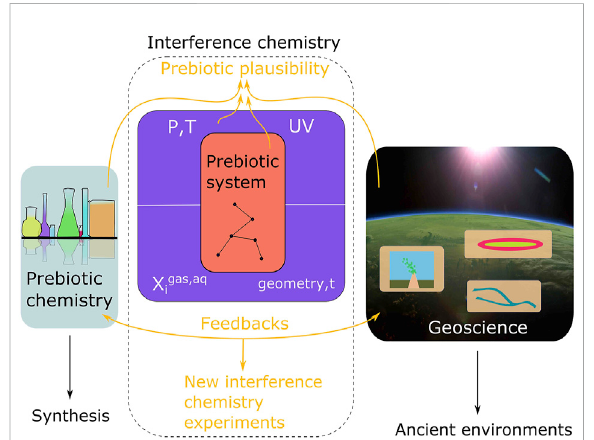
FIGURE 1 The scienti fi c context of interference chemistry. In prebiotic systems chemistry, an experimentally veri fi edsynthesis isplausible if all reactants may have co-occurred on early Earth in one or several linked environments (a scenario). In geoscience, theoretical and analytical constraints are leveraged to describe ancient environments in which prebiotic chemistry may have taken place. Interference chemistry is the interface between prebiotic chemistry and geoscience: the response of a chemical systemacrossarange ofapparentlyself-consistent environmental factors. From an interference chemistry perspective, a prebiotic scenario is plausible if a prebiotic system proves robust to those interferences associated with a proposed environmental setting. A critical caveat is the fact that constraints from prebiotic chemistry and geoscience are not fi nal, but instead should be weighted by the evidence available. Interference chemistry may therefore be leveraged to quantify and compare prebiotic plausibility for scenarios given the available chemical and geological evidence,